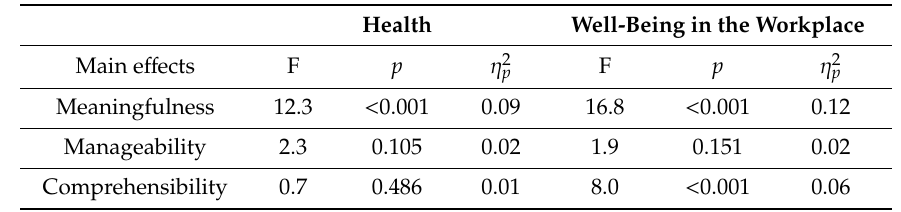
Table 4. Effects of the indicators for sense of coherence (SOC) on perceived health and well-being in the workplace ( n = 246). Health Well-Being in the Workplace